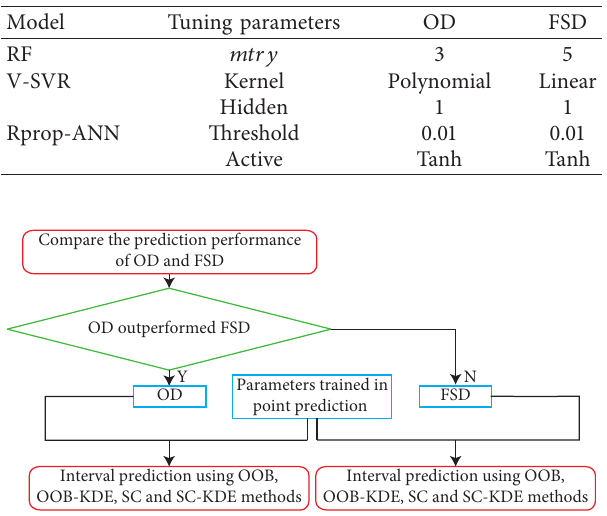
Figure 4: Flowchart of interval prediction of DGSR. Table 2: Error statistics of different models for DGSR